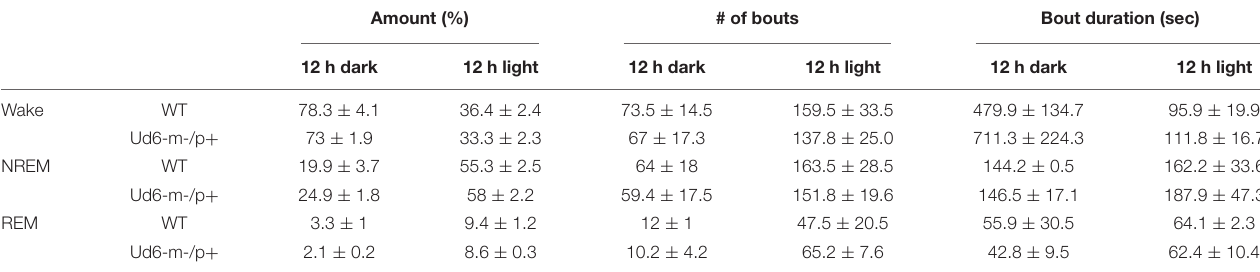
TABLE 2 | The number and duration of sleep and wake bouts in WT and Ud6-m-/p + mice in LD with access to a running wheel (mean ± SEM). Amount (%) # of